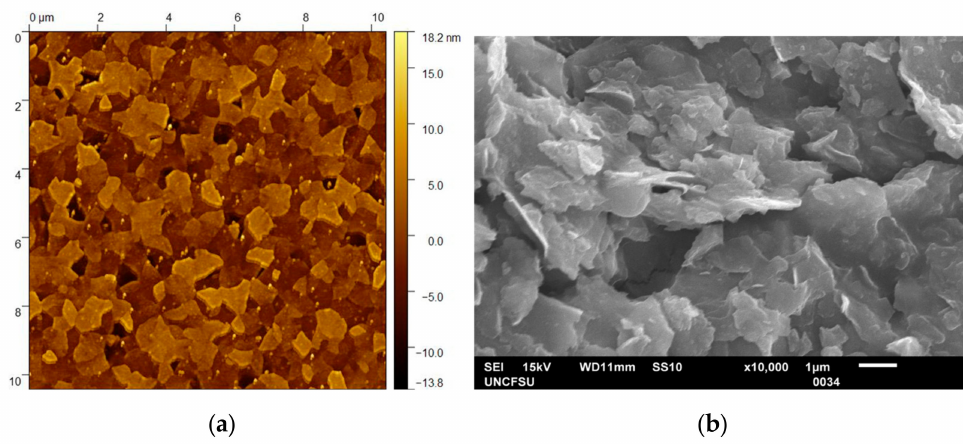
Figure 2. Topographic atomic force microscopy image ( a ) and scanning electron microscope (SEM) image ( b ) of Ti 3 C 2 T x